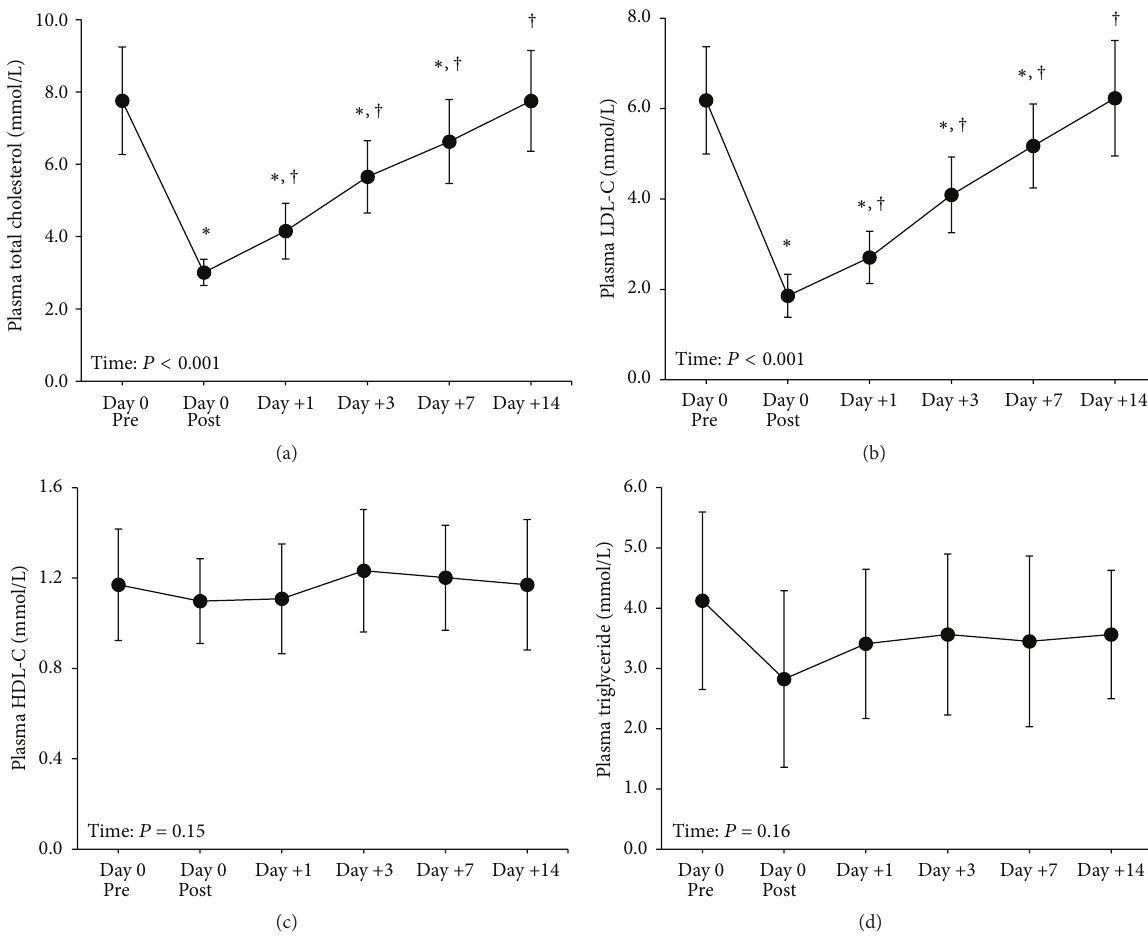
Figure 1: Plasma total cholesterol (a), LDL-C (b), HDL-C (c), and triglycerides (d) in patients ( 𝑛 = 5 ) prior to (Pre) and following LDL apheresis treatment. Data are means ± SD. LDL-C: low-density lipoprotein-cholesterol; HDL-C: high-density lipoprotein-cholesterol. ∗ 𝑃 ≤ 0.01 from Pre; † 𝑃 ≤ 0.01 from Post.